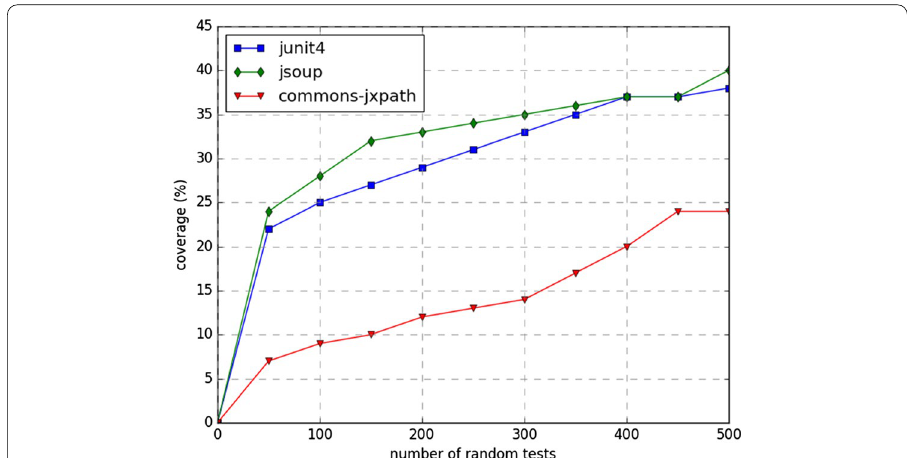
Fig. 1 Code coverage. Number of generated test cases and their related code coverage for some analysed software